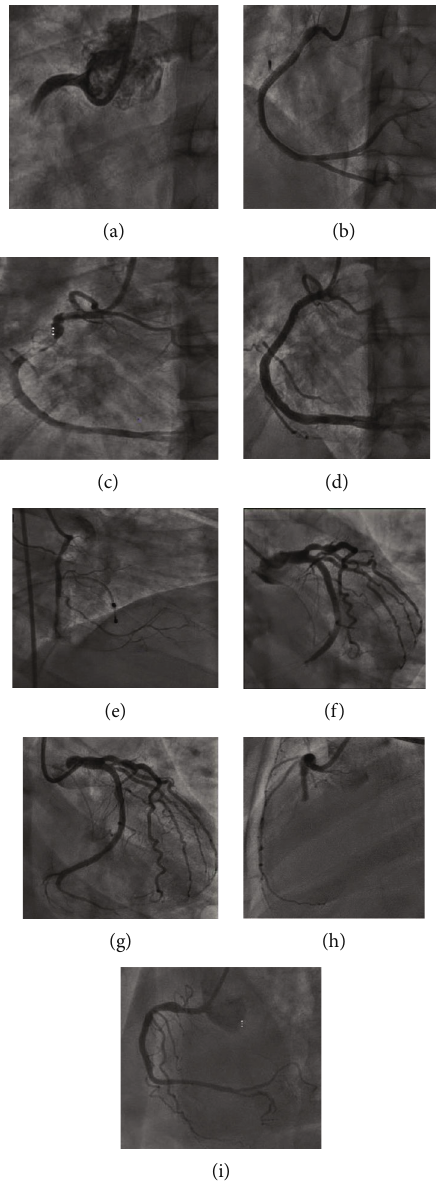
Figure 2: Coronary angiography to the culprit lesion. Case 1: (a) left anterior oblique (LAO) projection for right coronary artery (RCA), a thrombotic occlusion to proximal segment; (b) successful PCI to RCA with drug-eluting stent DES, and distal microembolization to very distal RCA happened with TIMI II fl ow distally. Case 2: (c) left anterior oblique (LAO) projection for right coronary artery (RCA) severe thrombotic stenosis in the proximal segment with TIMI II fl ow; (d) successful thrombus aspiration and PCI was done to RCA with one drug-eluting stent DES, and TIMI III fl ow was achieved. Case 3: (e) an attempt with balloon angioplasty was done to the thrombotic stenosis in mid-RCA but failed to achieve TIMI III fl ow. Case 4: (f) caudal projection showing 100% thrombotic stenosis in distal left coronary circum fl ex LCx; (g) successful PCI to distal LCx with one drug-eluting stent (DES) with TIMI III fl ow. Case 5: (h) total mid- RCA occlusion; (i) successful PCI to mid-RCA with one DES